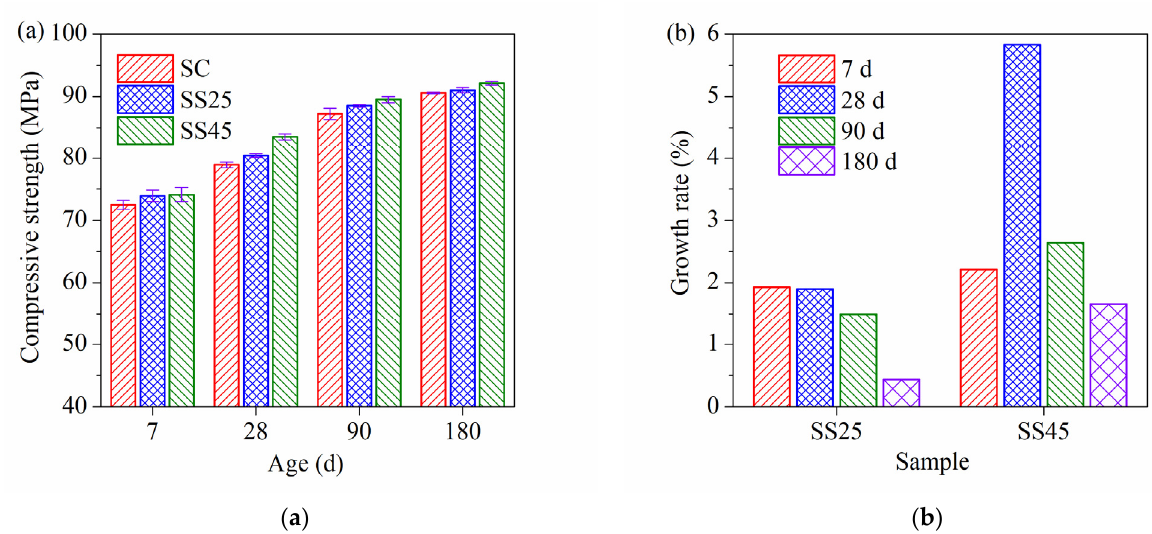
Figure 2. ( a ) Compressive strength of high-strength concrete under standard curing condition; ( b ) growth rate of compressive strength at different ages.